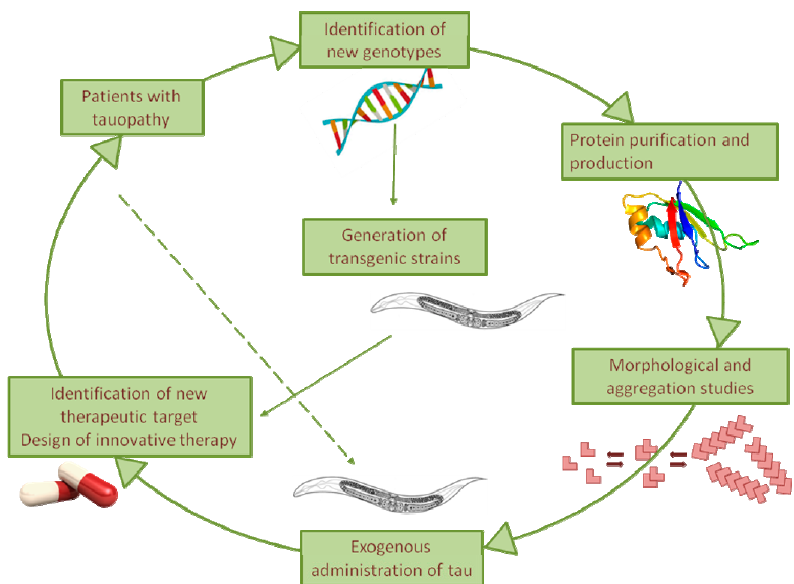
Figure 2. Overview of the C. elegans use as model for the elucidation of the pathogenic processes driving tau toxicity in tauopathies as well as the design of effective therapies.